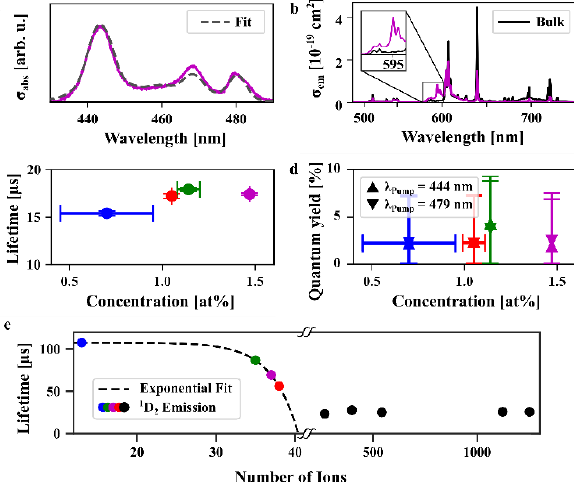
Fig 1: Results of spectroscopic investigations on LiYF nanocrystals. a) Absorption spectrum, b) Emission spectrum after excitation at 479 nm, c) Lifetimes of the 3 P 0 level, d) Quantum yield, e) Lifetimes of the 595 nm transition after excitation at 479